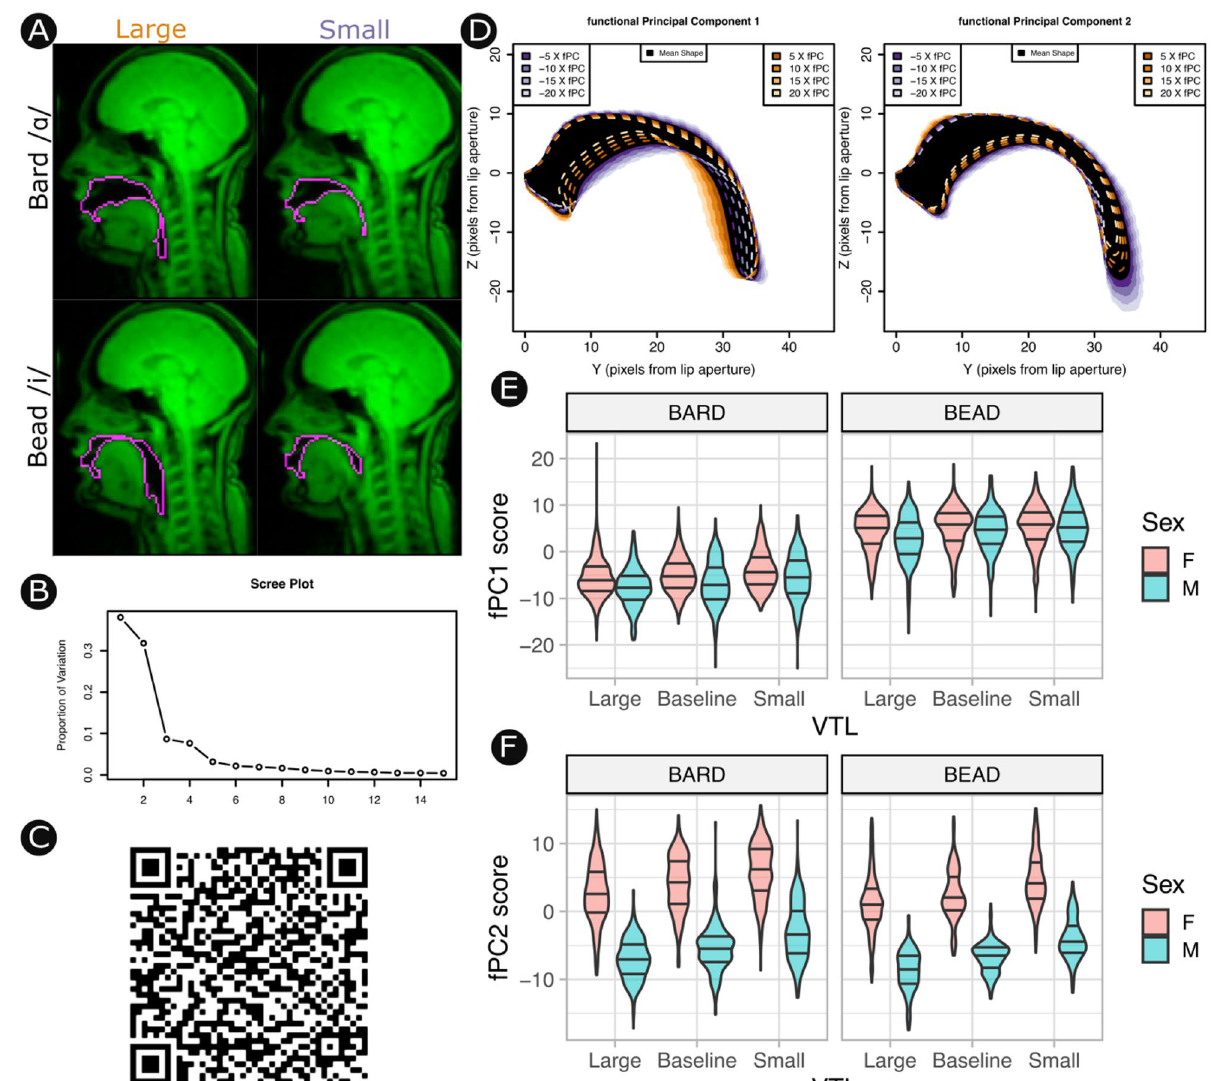
Figure 2. Variation in vocal tract shape. ( A ) Sample traces (pink) of the vocal tract from one speaker producing the vowels sounds in Bard (top) and Bead (bottom) while sounding large (left) or small (right). ( B ) Scree plot demonstrating that ~ 75% of variation in vocal tract shape is captured by functional principal components (fPC) 1 and 2, with fPC 3–5 being of potential interest but relatively small impact. ( C ) An interactive RShiny data visualisation can be accessed by scanning the QR code, or via the following link https:// miche lbelyk. shiny apps. io/ Varia tion_ in_ Vocal_ Tract_ Morph ology/. This companion app allows the user to interactively explore combinations of the first five fPCs and view the corresponding vocal tract shapes. ( D ) Static visualisations of fPC1 (left) and fPC2 (right) that provide interpretations for these components. The black area depicts the mean shape of the vocal tract; orange shading and lines indicate the vocal tract shapes that correspond to increasing fPC scores, while purple shading and lines indicate the vocal tract shapes that correspond to decreasing fPC scores. fPC1 has a clear interpretation as a continuum of tongue positions from a back position as is used to produce the vowel / ɑ / in Bard, to a front position as is used to produce the vowel /i/ in Bead. fPC2 has a clear interpretation as a continuum from a lowered larynx which elongates the vocal tract to a raised larynx with shortens the vocal tract. ( E ) Violin plots of fPC1 scores from all rtMRI frames by word, vocal tract length (VTL) condition, and sex. Horizontal lines mark the median and the interquartile range for each distribution. As expected for a component that loads onto tongue position, fPC1 clearly distinguishes between vowel sounds. ( F ) fPC2 scores. As expected for a component that loads onto vocal tract length, fPC2 clearly distinguishes between the sexes and vocal tract lengthening